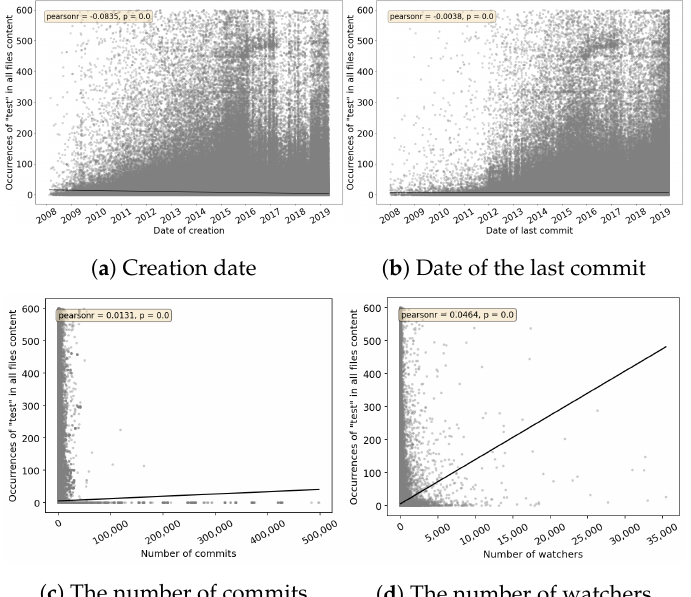
Figure A1. Correlation between the number of occurrences of the word “test” in all files content and project’s life cycle